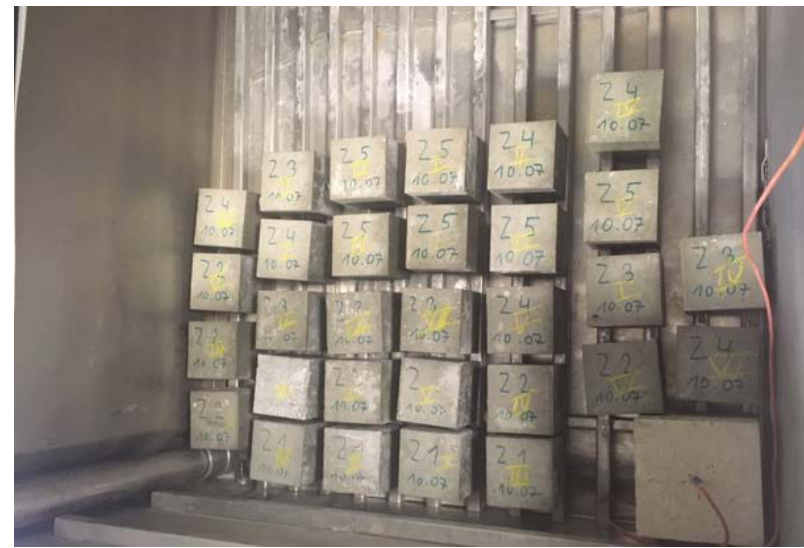
Figure 4. Samples prepared for frost resistance testing.